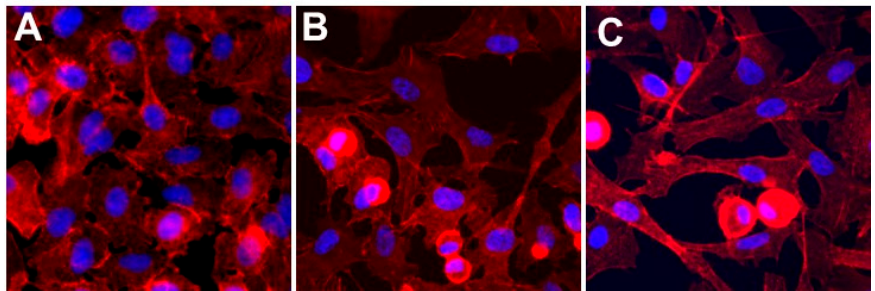
Figure 2. Experimental in vitro systems. In this study, three in vitro systems were utilized and include ( A ) the A549 human lung epithelial, ( B ) the A549/U937 epithelial/macrophage co-culture under static conditions, and ( C ) the co-culture model maintained within the presence of physiologically-representative fluid dynamics. In these representative images, actin and nuclei are shown as red and blue, respectively.